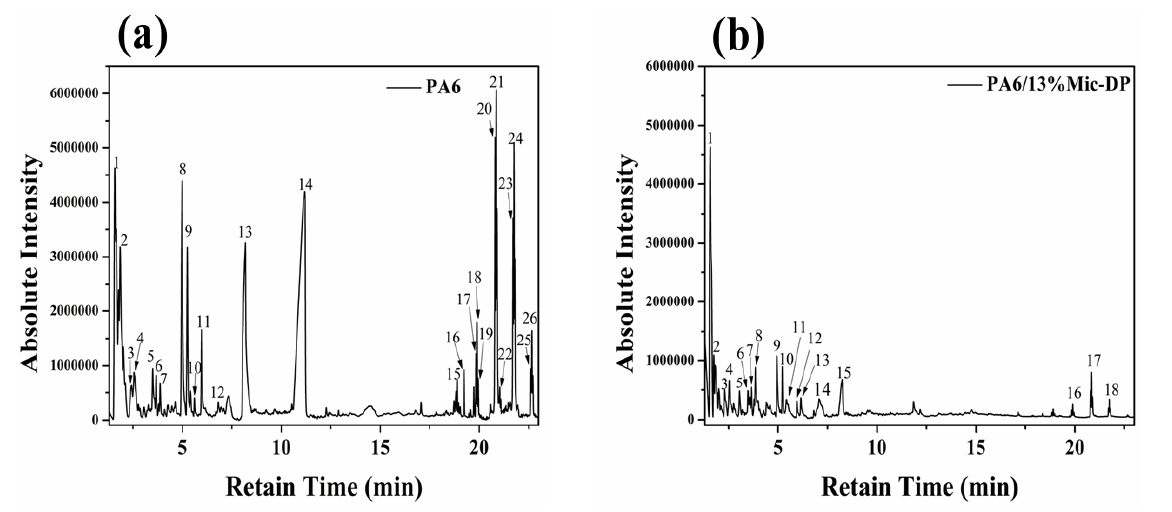
Figure 11. PY − GC − MS of ( a ) PA6 and ( b ) PA6/13%Mic − DP. Table 7. Attribution of peaks in PY − GC − MS results of PA6. Peak